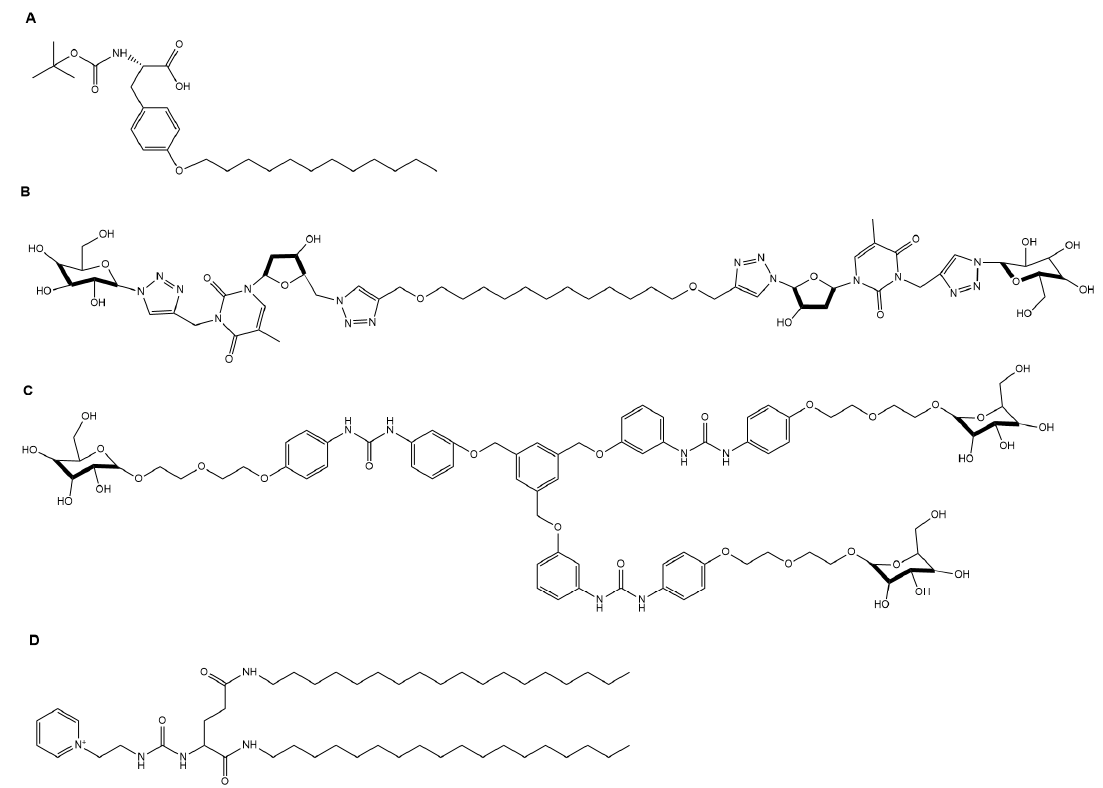
Figure 12. Selected gelators developed for biological applications: ( A ) a Boc- O -dodecyl- L -tyrosine gelator for the cryopreservation of cells [115]; ( B ) a bole-amphiphile gelator for cell culturing [116]; ( C ) a tris-urea hydrogelator for electrophoresis [117]; and ( D ) a cationic pyridinium-glutamide amphiphilic gelator for selective visual indication of the presence of adenosine triphosphate (ATP) [118].